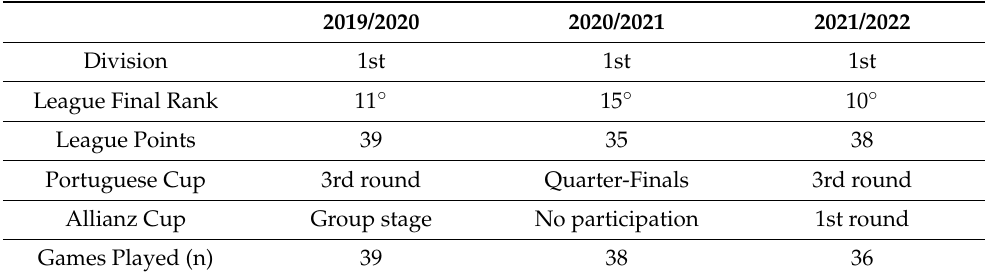
Table 1. Characteristics of the team competitive pathway during three sporting